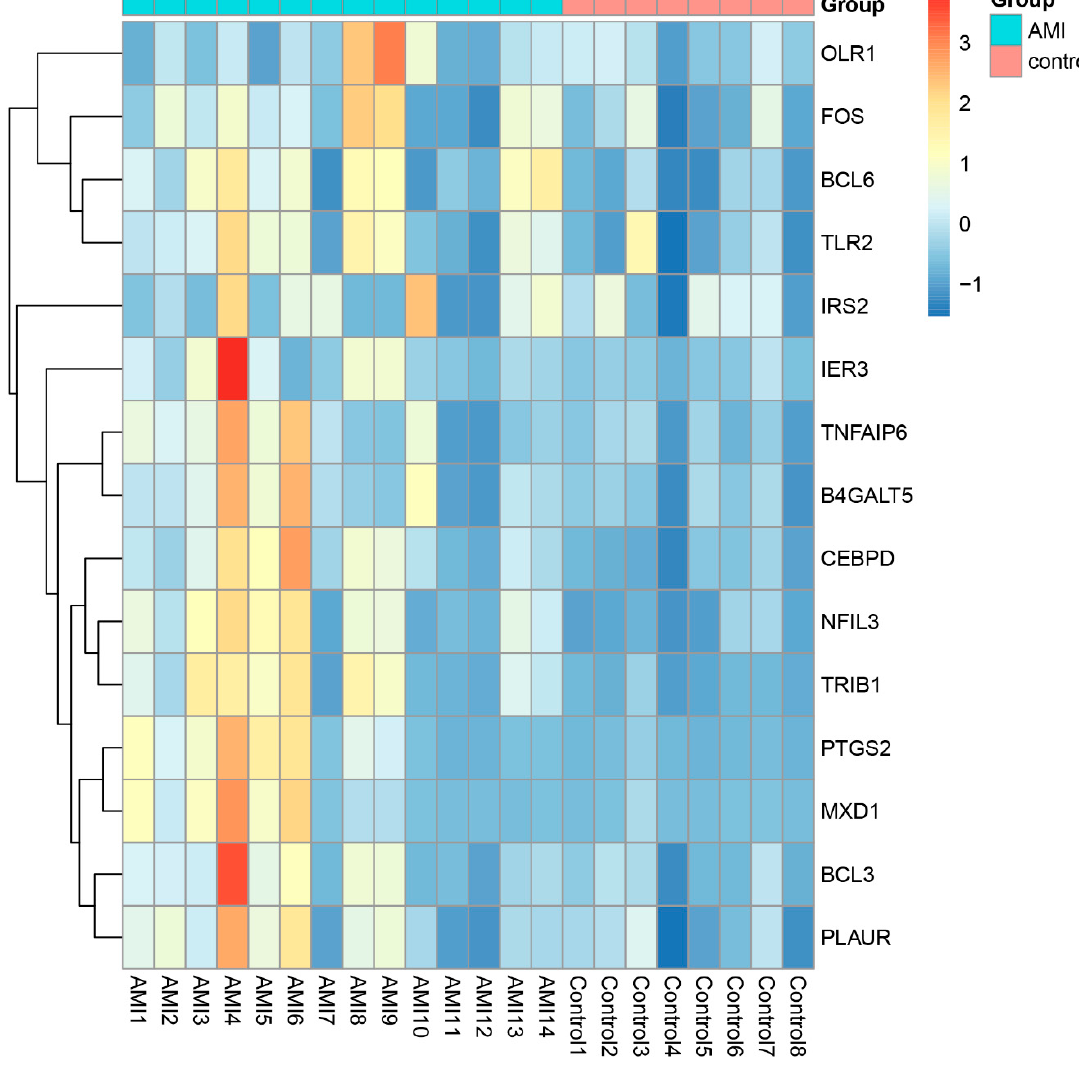
Figure 9. Validation of the gene set ‘TNFA_SIGNALING_VIA_NFKB’. Heatmap of the key genes of gene set ‘TNFA_SIGNALING_VIA_NFKB’ in the peripheral blood of AMI and controls.